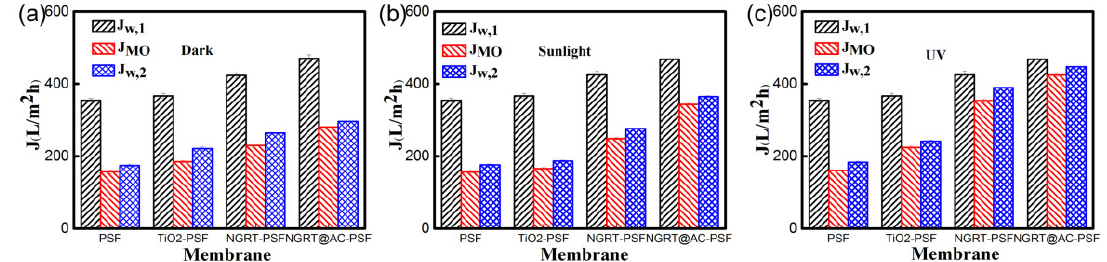
Figure 12. Flux values at different steps (pure water, MO solution, water cleaning) under ( a ) dark, ( b ) sunlight and ( c ) UV conditions.